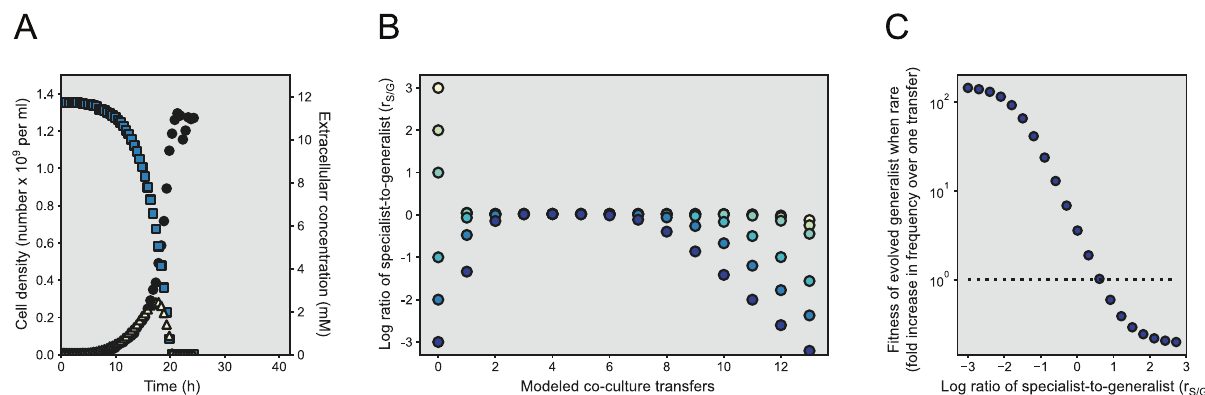
Fig. 7 Evolution of the generalist disrupts the cross-feeding interaction. A We grew phenotype A of the generalist alone in a bioreactor at pH 6.5 (strong nitrite toxicity) under anoxic conditions with nitrate as the growth-limiting substrate. Blue squares are measured extracellular nitrate concentrations, yellow triangles are measured extracellular nitrite concentrations, and black circles are measured cell densities. We measured extracellular nitrate and nitrite concentrations with IC and cell densities with FC. B In a three-species model, we introduced phenotype A of the generalist at a low initial frequency (1 × 10 – 8 ) and varied the initial r S/G . The model assumes that after each growth cycle, a small proportion of the ancestral generalist (1 × 10 – 8 ) mutates into phenotype A. Symbols show computed results at the end of each simulated transfer. C Using the three-species model, we introduced phenotype A of the generalist at a low initial frequency (1 × 10 – 8 ) and varied the initial r S/G . Symbols are the fold-increase in the frequency of phenotype A over one transfer. The dotted line separates the results depending on whether phenotype A has positive fi tness (above the line) or negative fi tness (below the